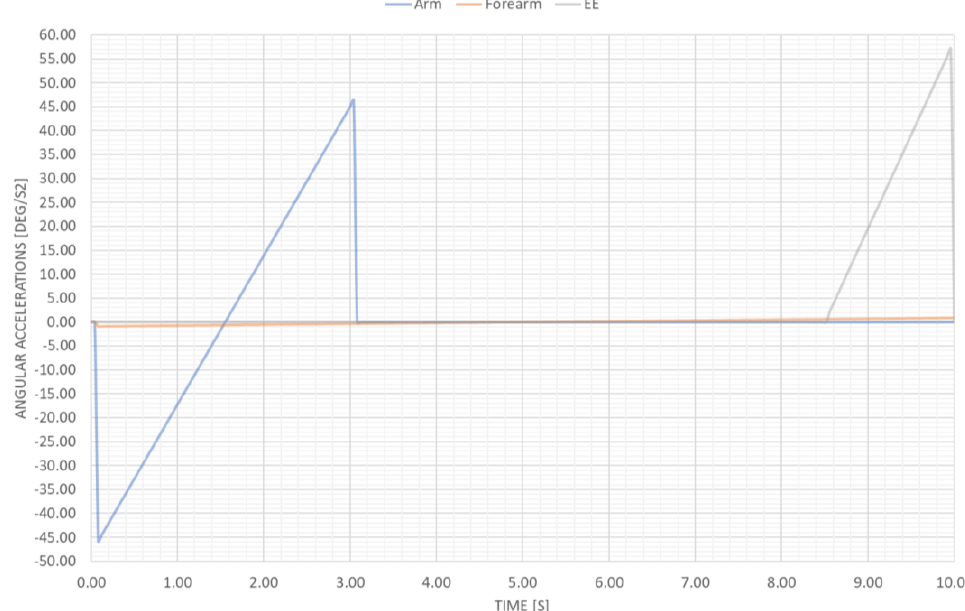
Figure 6. Computed results for the kinematic simulation in Figure 4 in terms of angular accelera- tions.